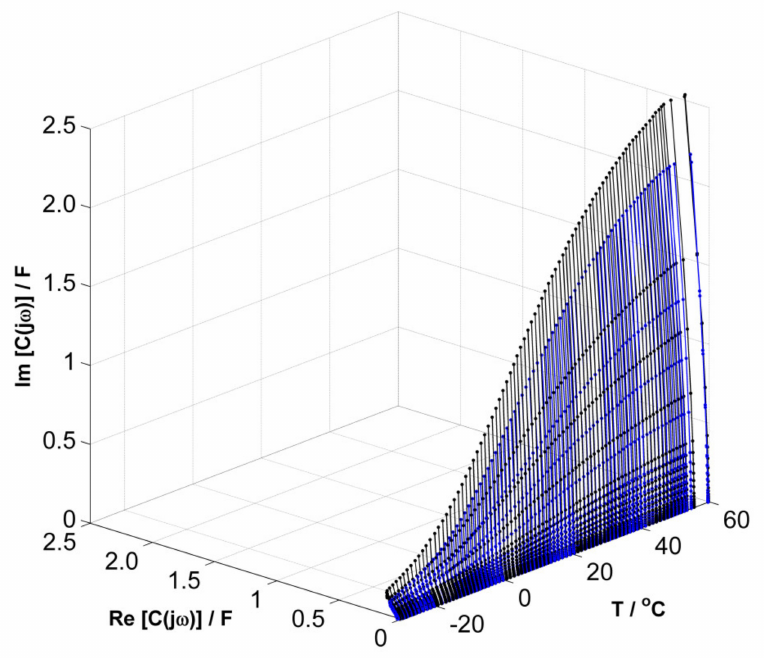
Figure 6. Comparison of complex capacitance spectrograms for the LiC during a dynamic tempera- ture change from − 30 to 60 degrees Celsius in static galvanic mode for SoC equal to 0% (blue line) and 100% (black